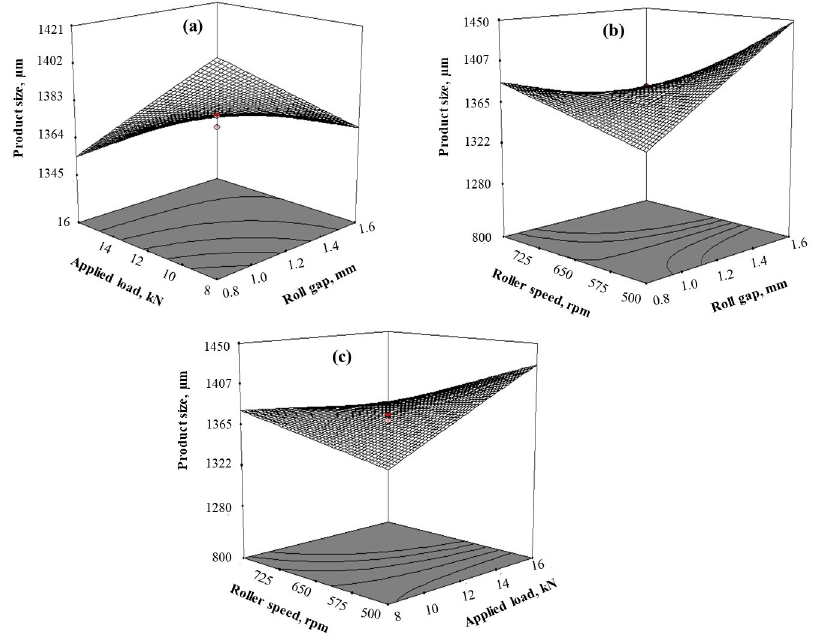
Figure 7. ( a – c ). Response surface plots showing the interactional effects of ( a ) roll gap-applied load, ( b ) roll gap-roller speed, and ( c ) applied load-roller speed for product size.